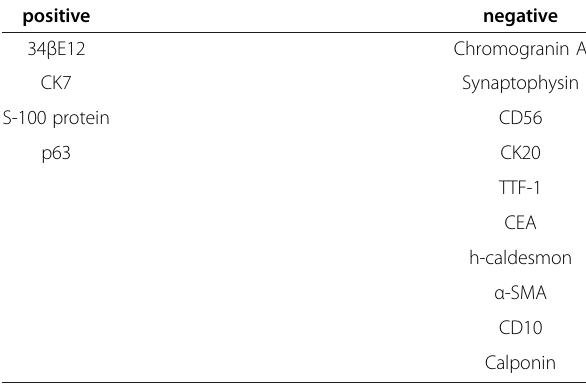
Table 2 Immunohistochemical profile of the carcinoma components in our case of BC of the